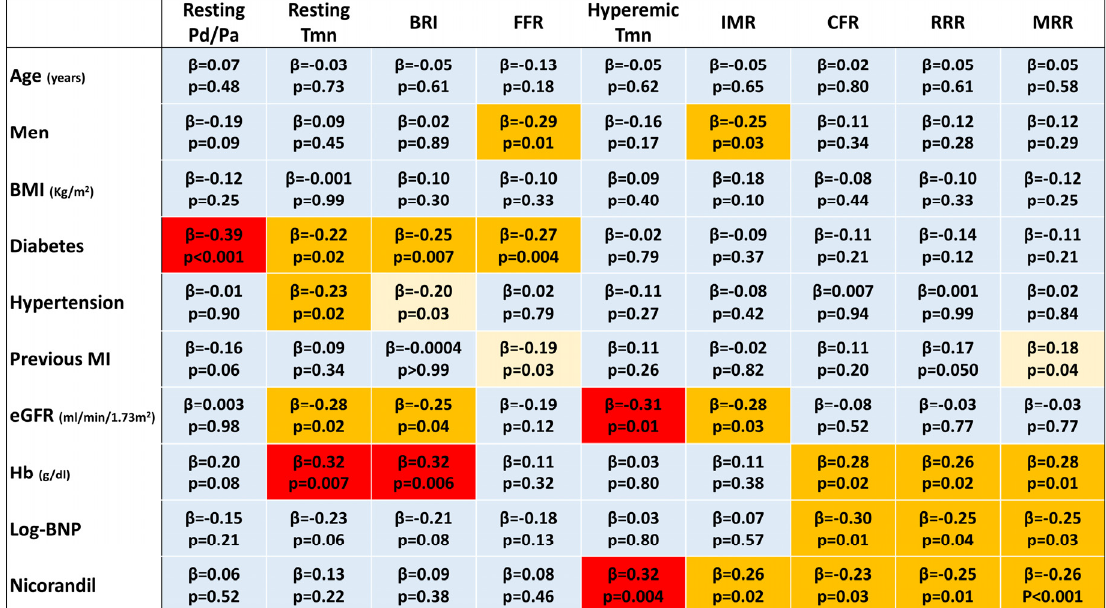
serve; Pd/Pa, ratio of distal coronary pressure to aortic pressure; RRR, resistive reserve ratio; Tmn, mean transit time.